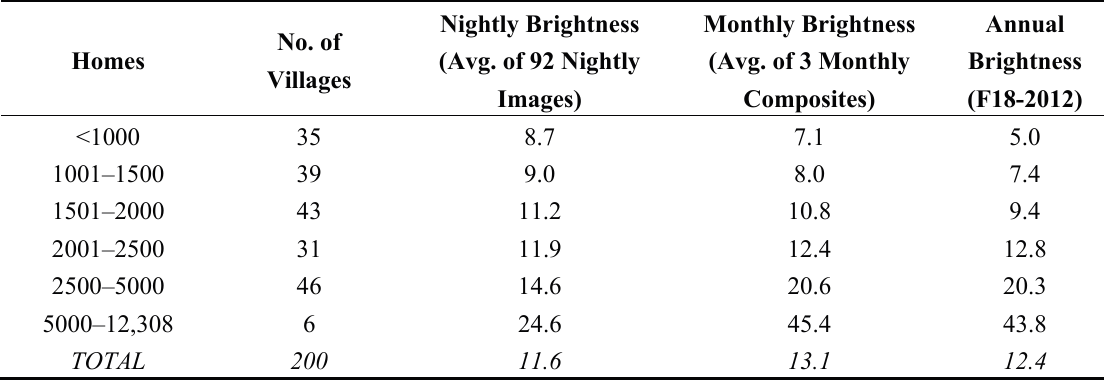
Table 3. Nighttime light output and electrified